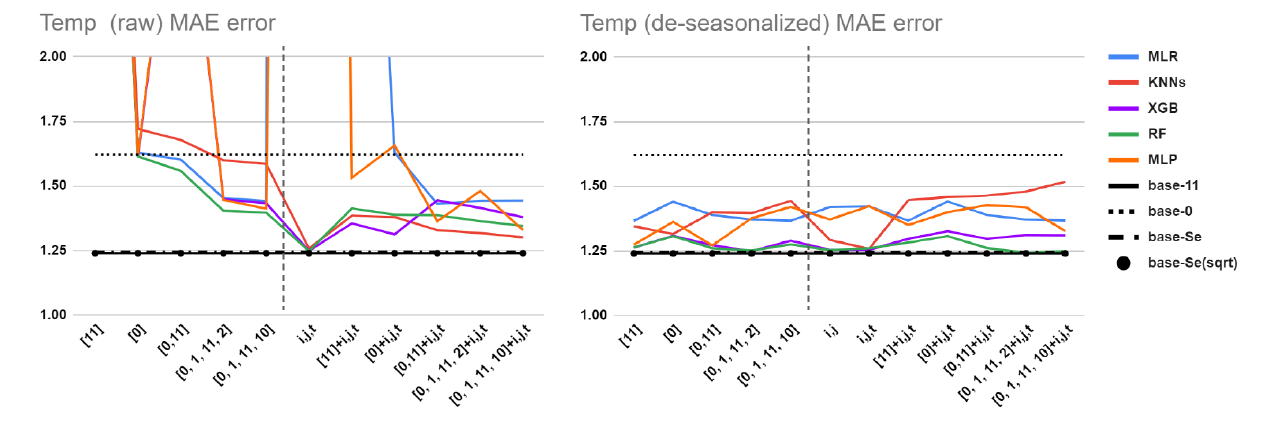
Figure 10. MAE for temperature predictions with different feature sets, for raw and de-seasonalized data sets.